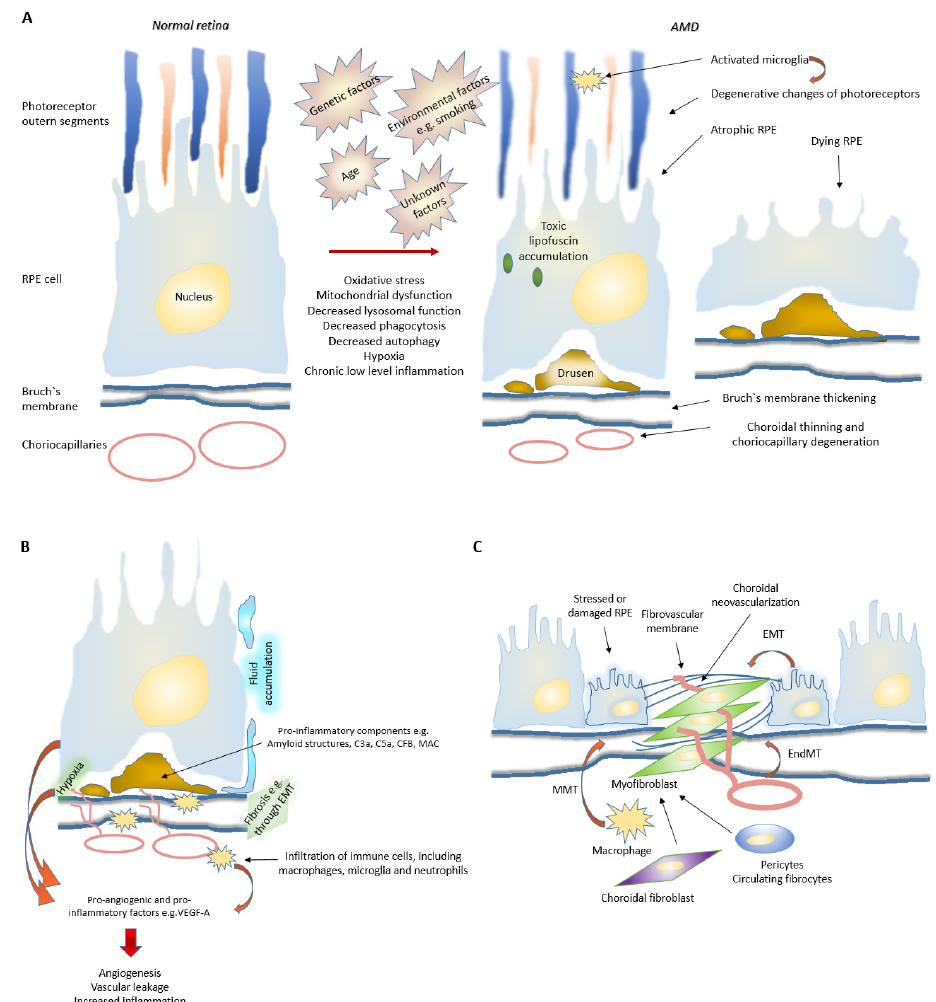
Figure 3. Mechanisms behind age related macular degeneration. ( A ) Age, light exposure, smoking, high-fat diet and unknown factors contribute to elevated oxidative stress, mitochondrial dysfunctions as well as decreased phagocytosis, autophagy and toxin clearance mechanisms in RPE cells. This leads to accumulation of intra- and extra-cellular waste products such as intracellular light absorbing lipofuscin and extracellular drusens. Affected retina may eventually face structural changes such as, RPE degeneration, photoreceptor loss, BrM thickening, choriocapillary degeneration, low-level inflammation and fibrosis. Activated microglia migrate to the outer nuclear layer to remove rod cell debris and, at the same time, may kill adjacent photoreceptors. ( B ) During an angiogenic switch, inflammatory cell recruitment is initiated, and as newly formed vessels are leaky, they contribute to retinal edema, hemorrhage and therefore further potentiate the pathological wound healing response. In nAMD, there exist many mechanisms how neovascularization and low-level inflammation can be stimulated. For example, damaged RPE produces excessive amounts of growth factors, which stimulate vascular growth. In addition, BrM thickening and drusens increase distance of RPE cells from choroidal vasculature and thus increases hypoxia, which in turn will upregulate pro-angiogenic and pro-inflammatory growth factors. Interestingly, drusens also consist of pro-inflammatory components, such as amyloid structures and C3a. Furthermore, accumulating immune cells may secrete inflammatory cytokines and angiogenic growth factors and therefore support the disease progression. ( C ) In nAMD, fibrosis is the product of defective and excessive wound healing response. It is believed that pro-inflammatory cytokines can promote differentiation and activation of matrix-producing myofibroblasts (e.g., EndMT and EMT). Multiple cell types, including